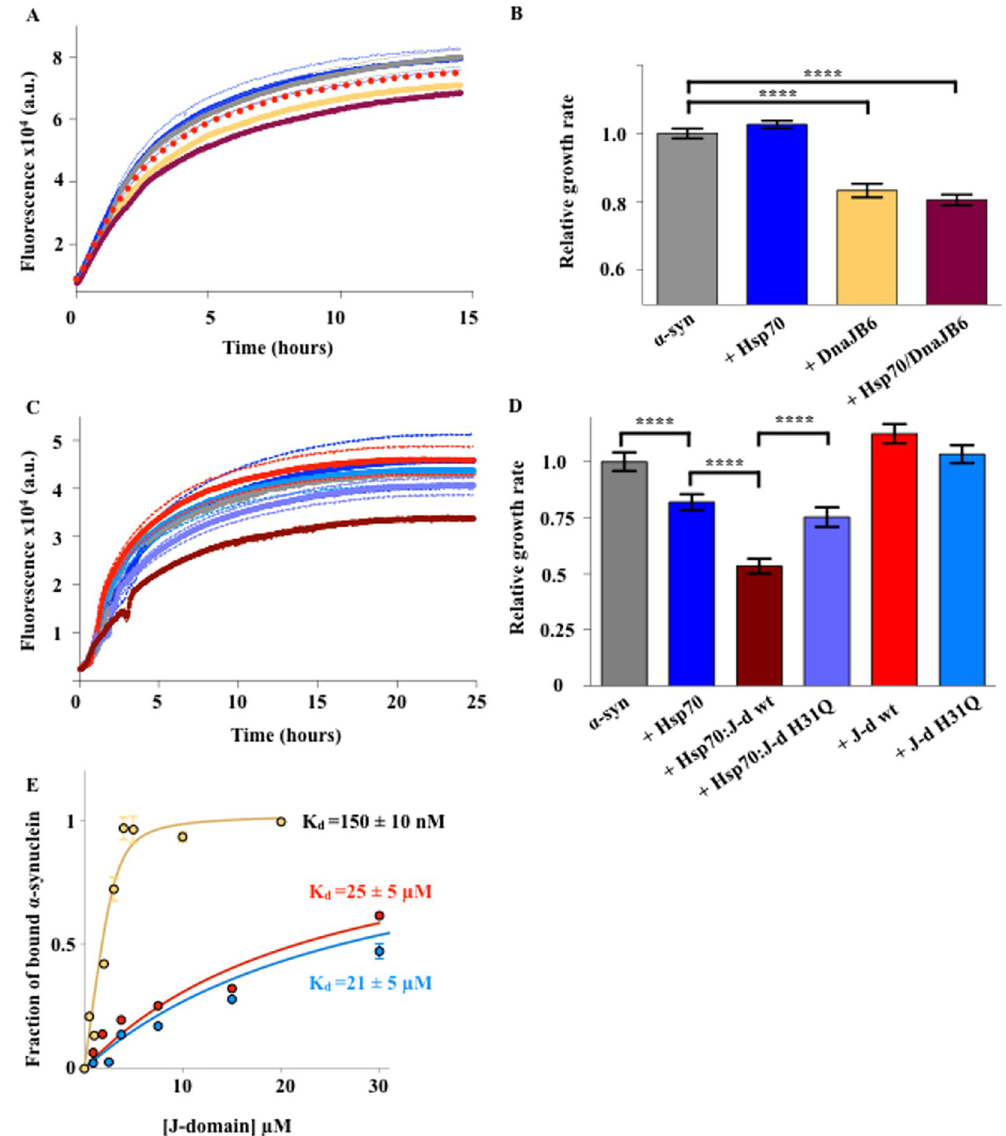
Figure 5. Effect of DNAJB6 on the aggregation of α -syn. ( A ) Seeded aggregations of α -syn alone (grey) or in the presence of either 0.5 µ M Hsp70 (blue), 0.15 µ M DNAJB6 (yellow), or 0.4 µ M Hsp70 and 0.1 µ M DNAJB6 (maroon). Individual values are the mean of four independent experiments. The red dashed line is the sum of the concentration-corrected effects derived from the blue and yellow lines, which corresponds to the theoretical aggregation profile in the presence of 0.4 µ M Hsp70 and 0.1 µ M DnaJB6 if their effect was simply additive. ( B ) Bar plot of the initial velocities of the aggregation reactions in ( A ) normalised on the value of α -syn alone. ( C ) ThT aggregation experiments in seeding conditions of α -syn in the absence (grey) or in the presence of either 0.5 µ M Hsp70 (blue), wt J-domain (red), H31Q J-domain (cyan), Hsp70:wt J-domain (maroon) or Hsp70:H31Q J-domain (violet). ( D ) Bar plot representing the initial growth rates of aggregation from panel (C) normalised on the value of α -syn alone. ( E ) Fluorescence binding assay of DnaJB6 (yellow), wt J-domain (red), or H31Q J-domain (cyan), to Alexa488- α -synuclein. The apparent K d s of binding are reported on the side of each curve. Statistical analysis was performed by one-way ANOVA with post-multiple comparison (99% CI, * P ≤ 0.05, ** P ≤ 0.01, *** P ≤ 0.001, **** P ≤